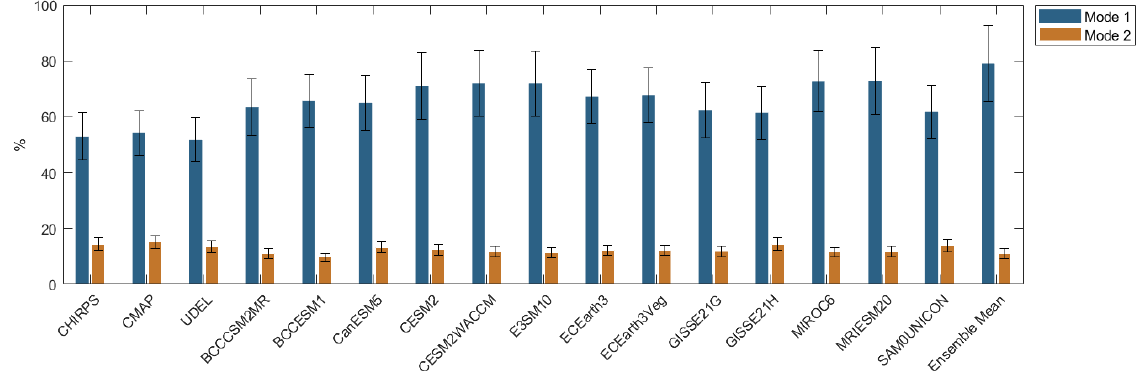
Figure 11. Variance explained by the first two EOF modes with sampling error bars.